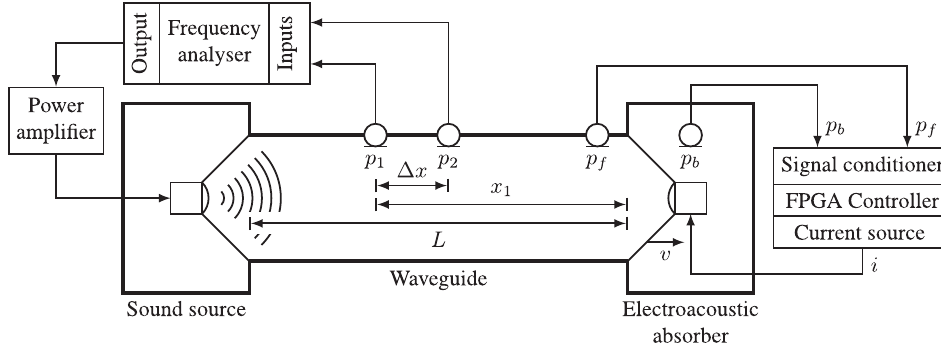
Figure 7. Schematic of the experimental setup used to measure the impedance presented by the